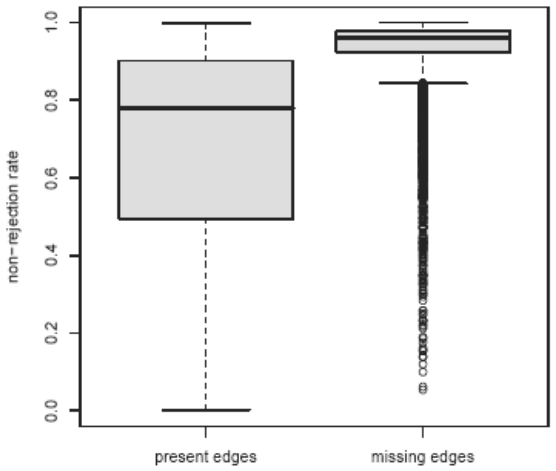
Figure 2 – Boxplots of the estimated values of the non-rejection rate for the 1206 present edges and for the 12160 edges of G= (20) G